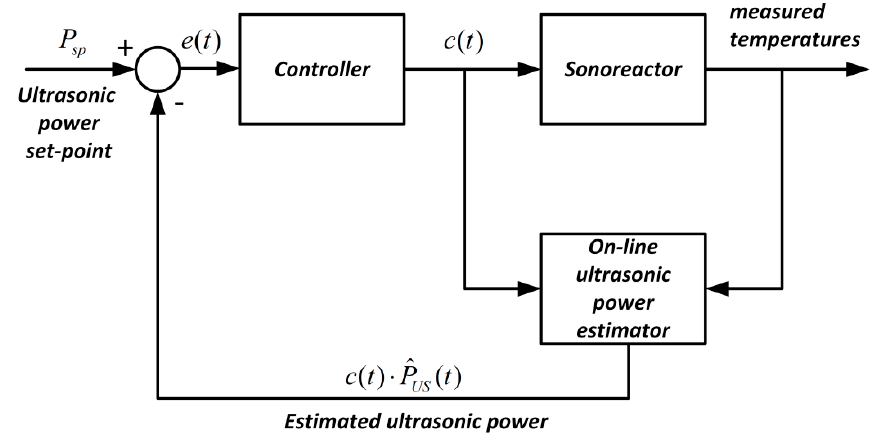
Figure 6. Scheme of the control system for stabilization of the ultrasonic power. 221